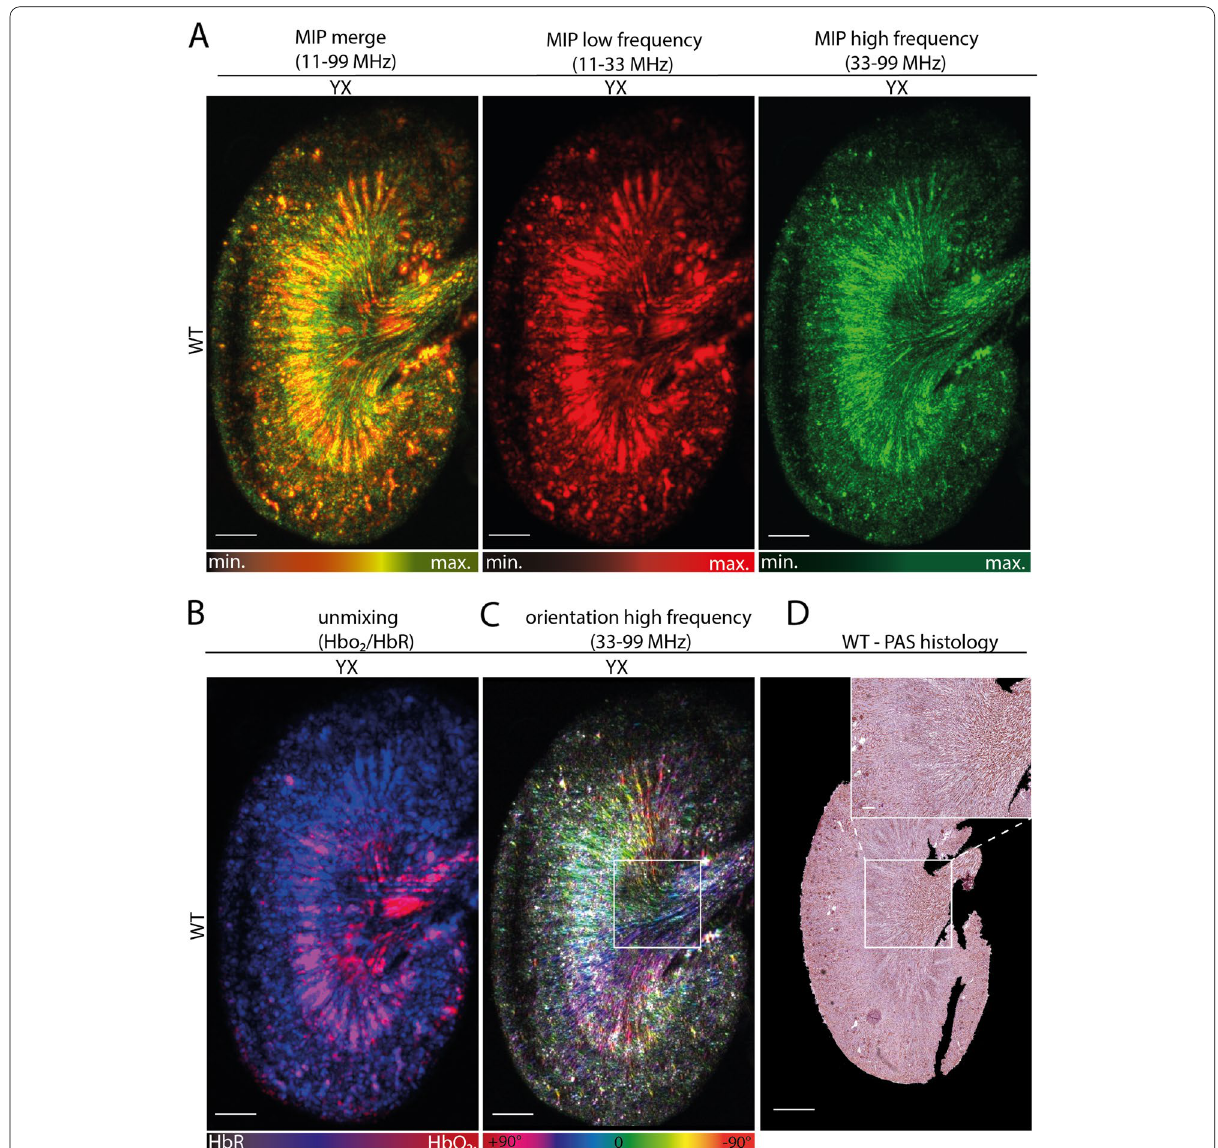
Fig. 5 Multispectral raster scanning optoacoustic mesoscopy imaging. A Exemplary reconstructed cross-sectional msRSOM maximum intensity projections (MIP) of a wildtype mouse kidney are displayed. Merged frequencies (red-green) combine the information from low frequencies (bigger vessels red) and higher frequencies (smaller vessels green) allowing visualization of renal vasculature similar to images from RSOM (Figs. 1 = = and 3) at the same SWL of 532nm. Scale bars indicate 1mm. B Exemplary reconstructed cross-sectional msRSOM maximum intensity projection (MIP) of spectrally unmixed msRSOM parameters (blue HbR and red HbO 2 ) from four wavelengths (532, 555, 579, 606nm). HbR indicating = = deoxygenated - venous and HbO 2 indicating oxygenated–arterial blood in the freshly excised and halved kidney. Scale bars indicate 1mm. C The same image as shown in B coded for vessel orientation by an image processing software. Orientation of the vessels from the kidney hilus to the periphery is visualized confirming normal anatomical distribution and orientation. Scale bars indicate 1mm. D A histological section of the kidney shown in A – C. PAS staining confirms the anatomical distribution and orientation of kidney tissue and vessel orientation. A 5-fold magnification of a central kidney section (rectangle 2x2mm) is shown. Scale bars indicate 1mm and 0.2mm in the magnification. LF low frequency, HF high = = frequency, MF merge frequency, HbO 2 oxygenated hemoglobin, HbR deoxygenated hemoglobin, WT wildtype, PAS period acid-Schiff’s, = = = = = min. minimum, max. = =